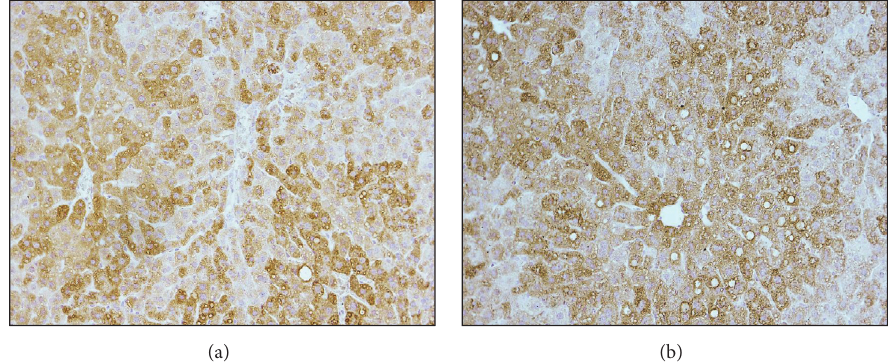
Figure 8: Neutralising ADAM19 does not affect the expression of ADAM19 in the liver. Representative photomicrographs showing ADAM19 immunohistochemistry performed on livers from HFD-fed mice administered either rabbit IgG control (a) or ADAM19 neutralising antibody (b). ADAM19 staining is cytoplasmic and brown in colour. 200x